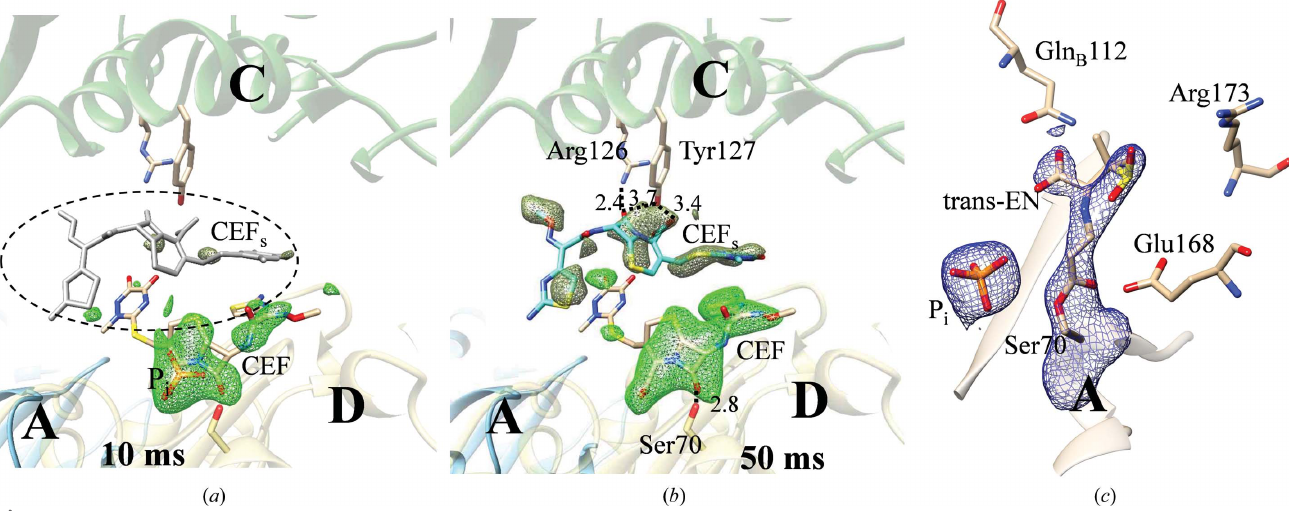
Figure 5 Additional ligands. ( a ) CEF in the active site and the stacking site (dotted oval) located between subunits D and C . A DF o (cid:4) mF c OMIT difference electron-density map in the active site is shown in green and that in the stacking site in gray–green (at a 2.5 (cid:6) contour level). Substantial CEF density in the active site is shown in green. There is also electron density for P i present due to averaging over all unit cells in the crystal. The stacking site is not occupied (gray CEF s molecule). ( b ) At 50 ms the maximum occupancy of CEF in the active center is reached. The stacking site is substantially occupied (blue CEF molecule). Important residues and distances are marked in A˚ . ( c ) The covalently bound trans -EN is present in subunit A of the static cryostructure of BlaC when soaked with SUB (blue; 2 F o (cid:4) F c map at a 1.5 (cid:6) contour